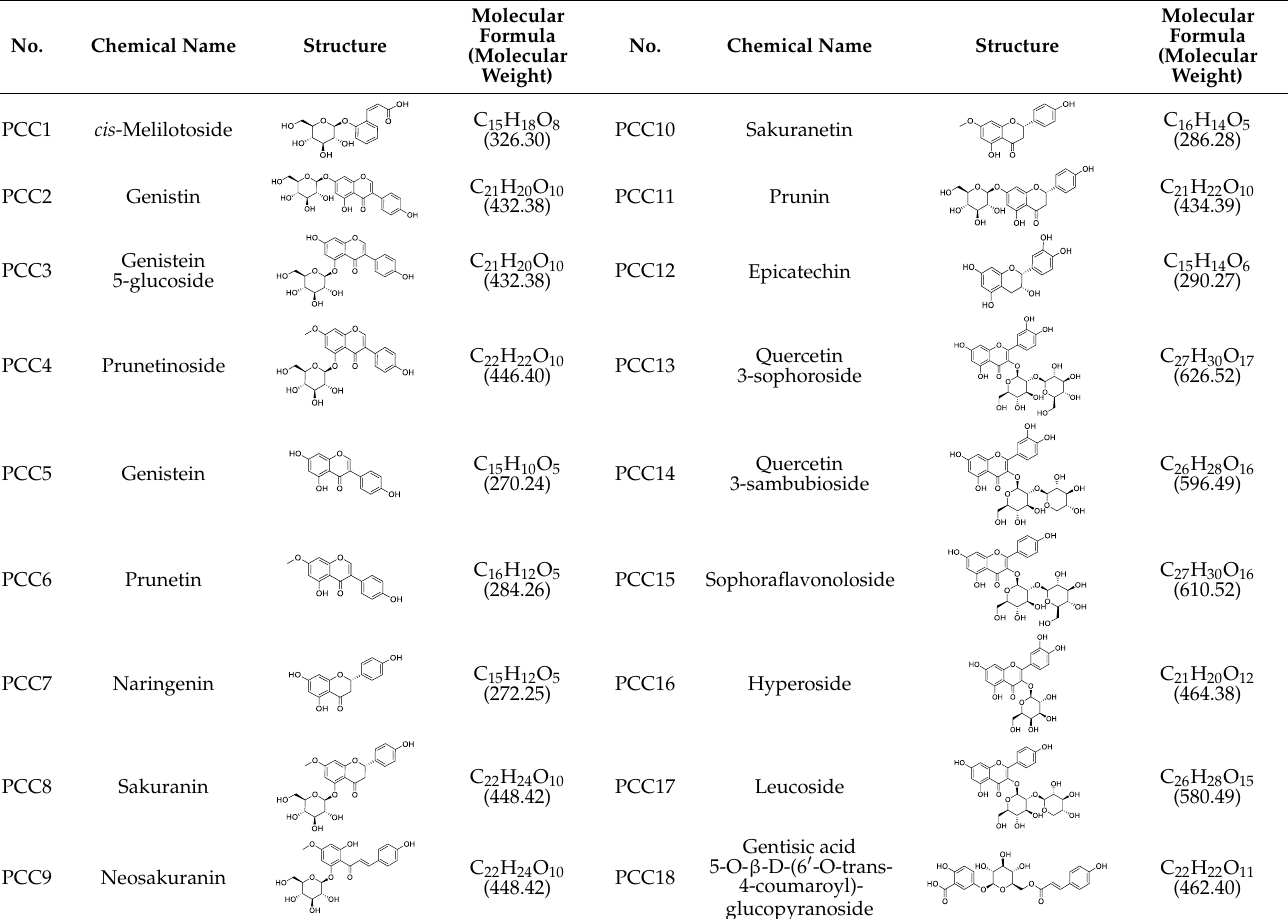
Table 1. List of 18 compounds identified from PCE.